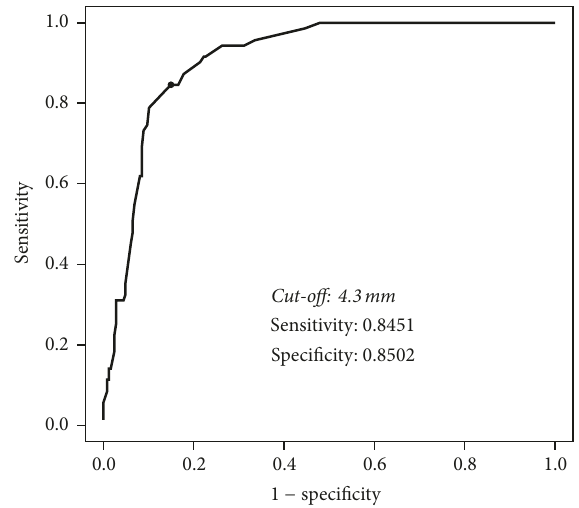
Figure 2: Receiver operating characteristic (ROC) curve of the amountofmedialmeniscalextrusion(MME)forkneepain.Thecut- off value of MME for knee pain is 4.3 mm, with sensitivity of 0.8451 and specificity of